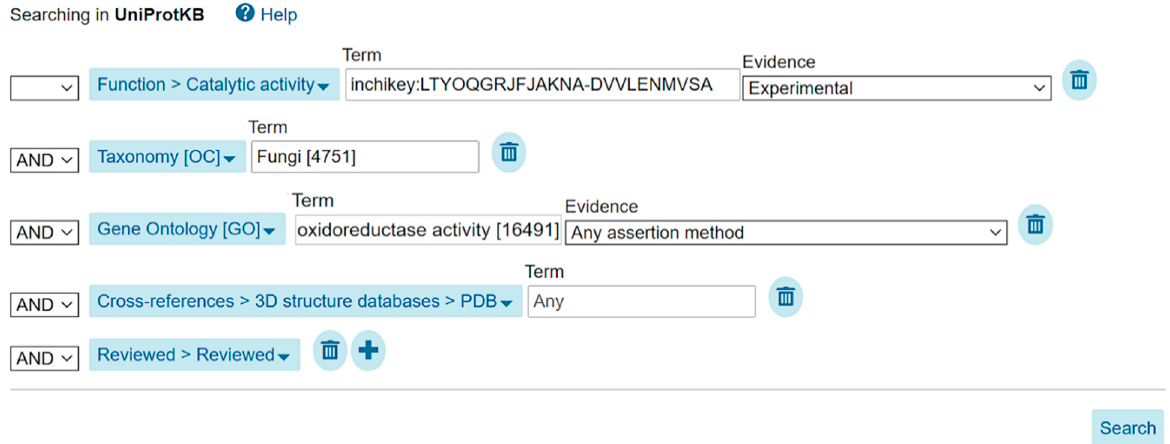
Figure 4. Sample query using the UniProt website advanced search tool to retrieve, in UniProtKB/Swiss-Prot, fungal oxi- doreductases that metabolize malonyl-CoA, with published 3D structure(s). The query retrieves expert-curated (Field: Reviewed > Reviewed) oxidoreductases (Field: Gene Ontology [GO], Term: “oxidoreductase activity [16491]”) of fun-